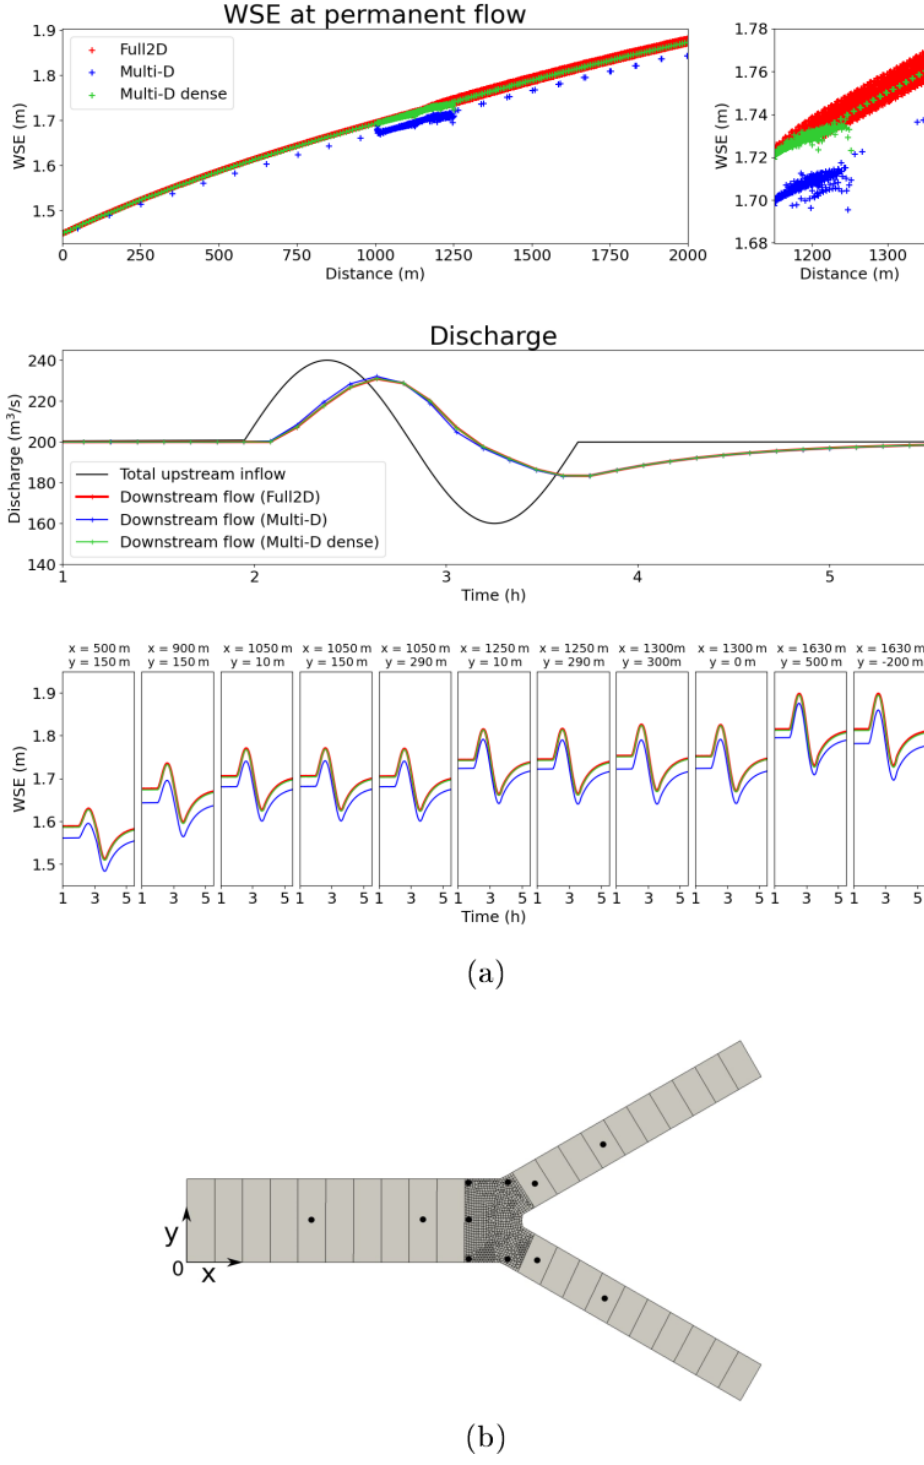
Figure 7. Multi-D confluence case results with second-order scheme. (a) Top: waterlines for a permanent flow of 100m 3 s − 1 at both upstream boundaries; reference 2D waterline (red); waterline for the mesh in (b) (blue); waterline for a denser 1D–2D mesh (not shown, green). Middle: total upstream discharge during sample varied flow event (evenly distributed between upstream boundaries, blue); downstream simulated flow for the considered meshes (red/green/blue). Bottom: WS elevation observations for the varied flow event. (b) Multi-D mesh. Station locations are noted as black